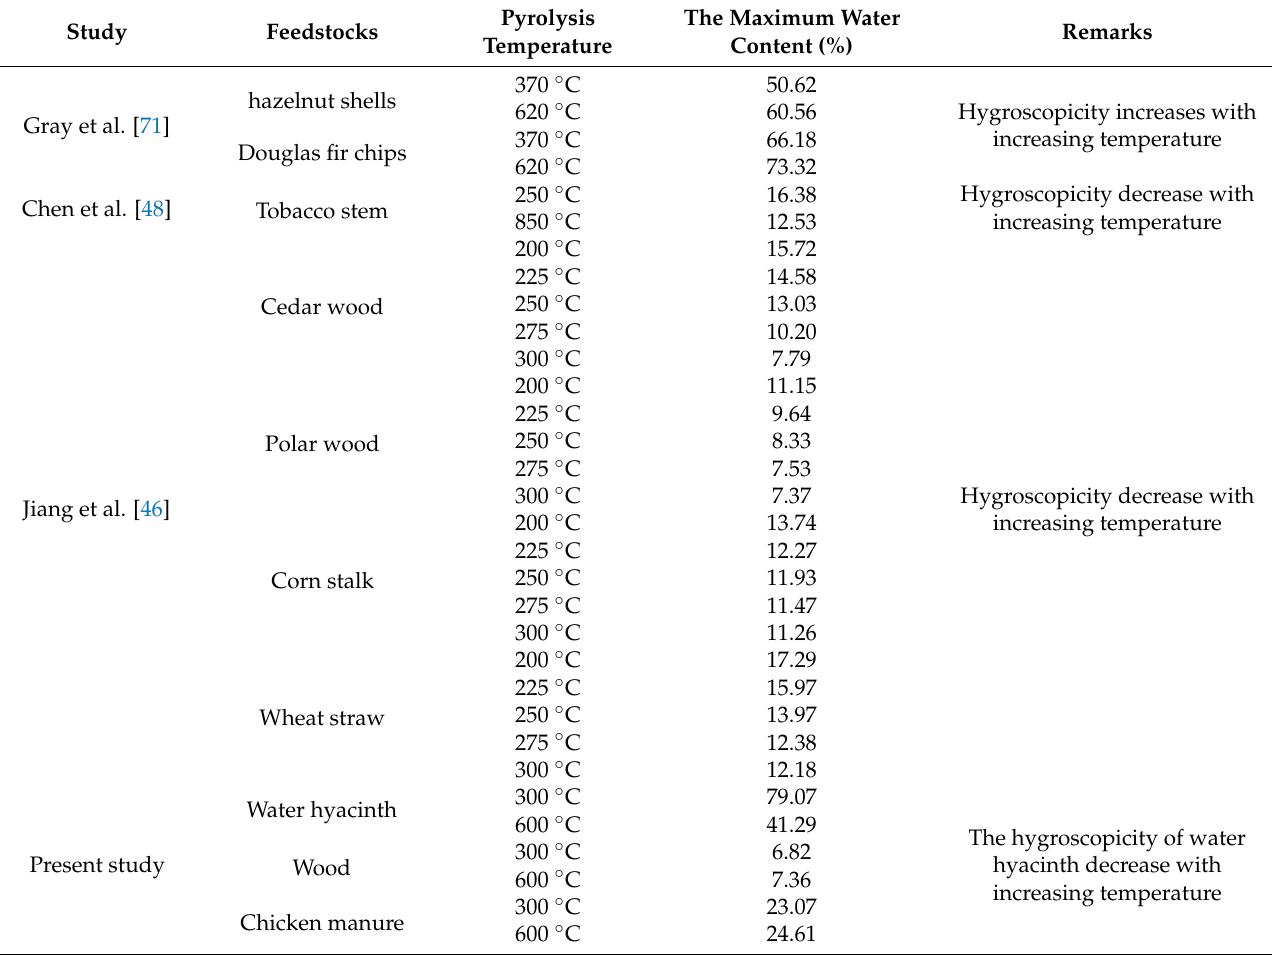
Table 6. The performance of biochar on